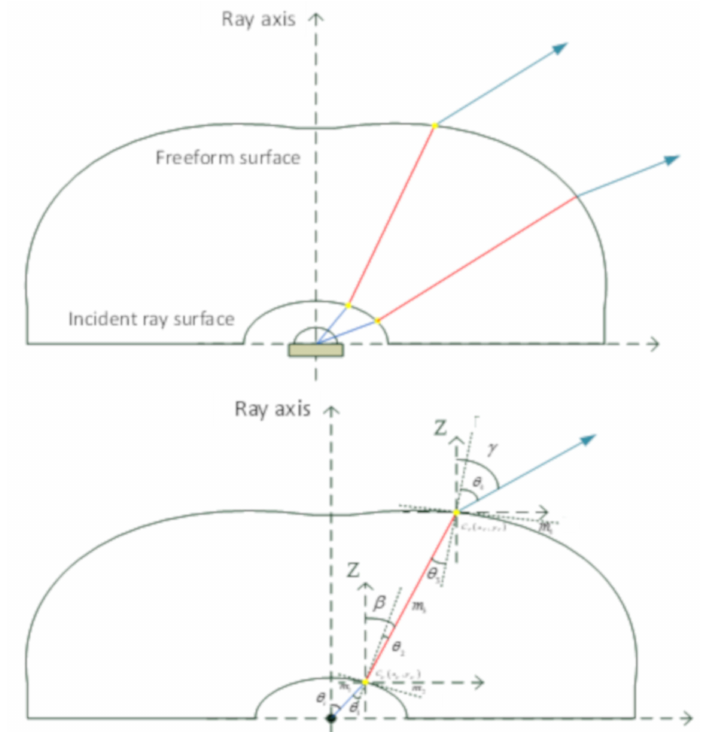
Figure 7. Mathematical model of a roadway lighting